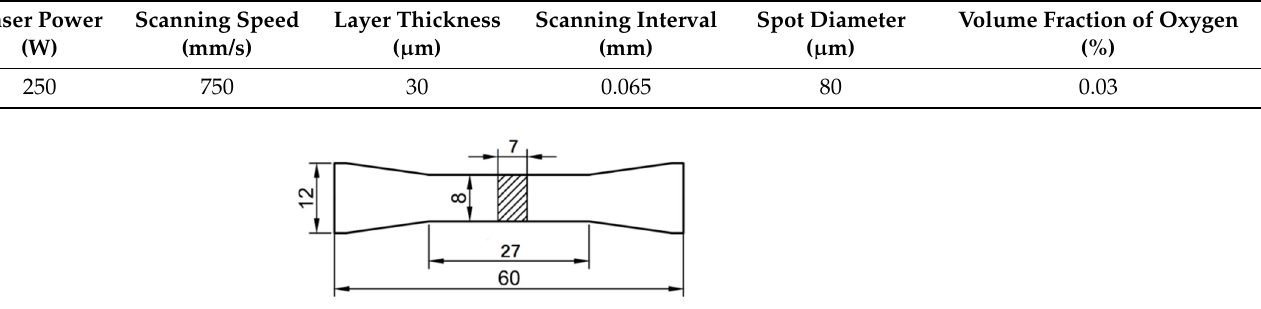
Figure 1. Schematic diagram of the SLM 316L stainless steel specimen.